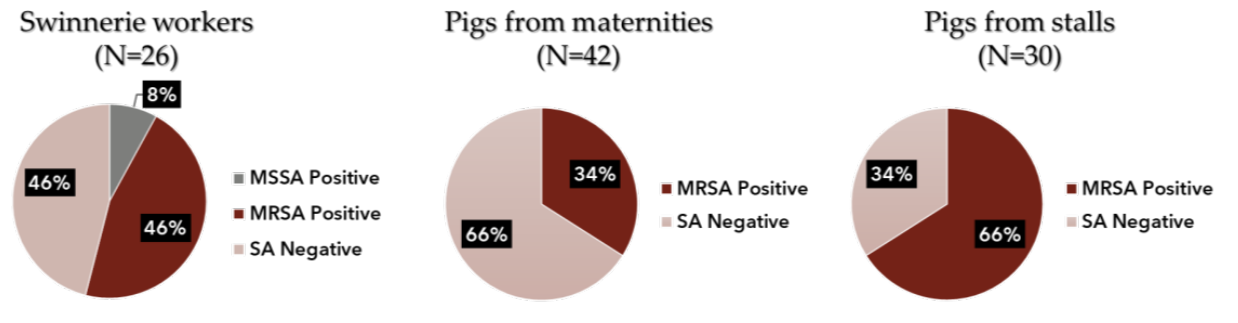
Figure 1. MRSA prevalence in the swinneries.